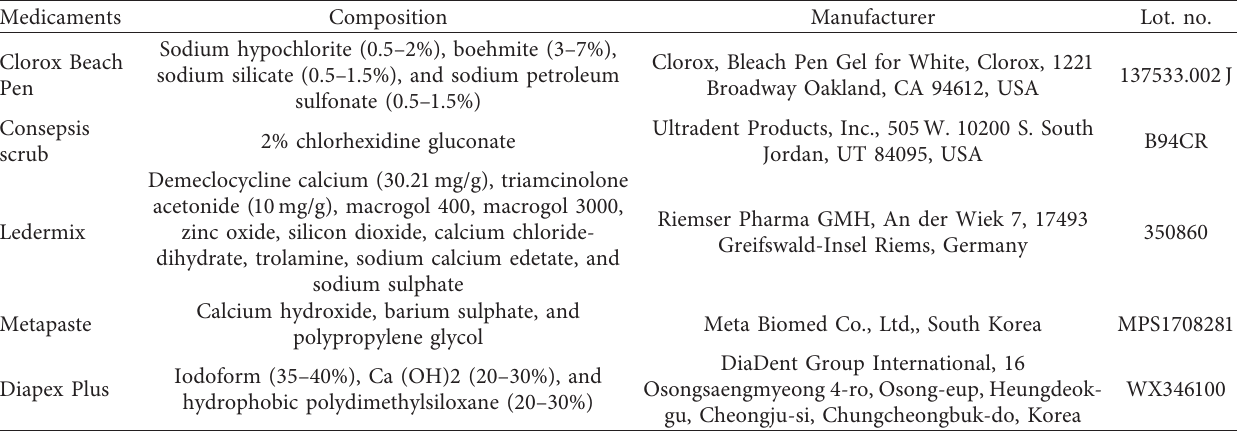
Table 1: Experimental intracanal medicaments.